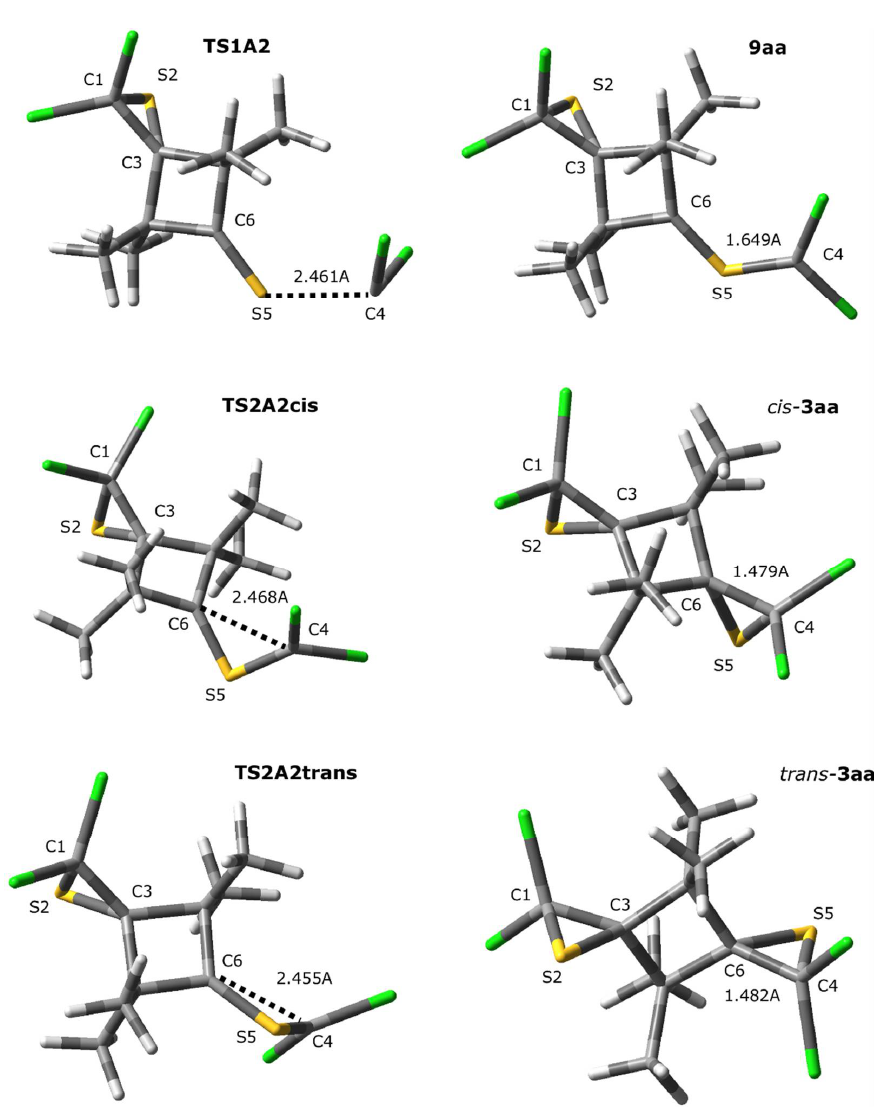
Figure 5. Views of key structures for 8aa → cis - 3aa / trans - 3aa transformation in the reaction starting with carbene 1a and thioketone 2a in the light of wb97xd/6-311g(d,p)(PCM) computational study. At this point, it should be underlined that the more favored kinetical channels of the cyclisation of 9aa proceed via TS2A2 cis transition state and lead to formation of bis- spiro - adducts with cis configuration of heterocyclic rings in the target molecule. General, mech- anistic scheme of addition of dichlorocarbene ( 1a ) with 2,2,4,4-tetramethyl-cyclobutane- 1,3-dithione ( 2a ) is presented in Scheme 4.